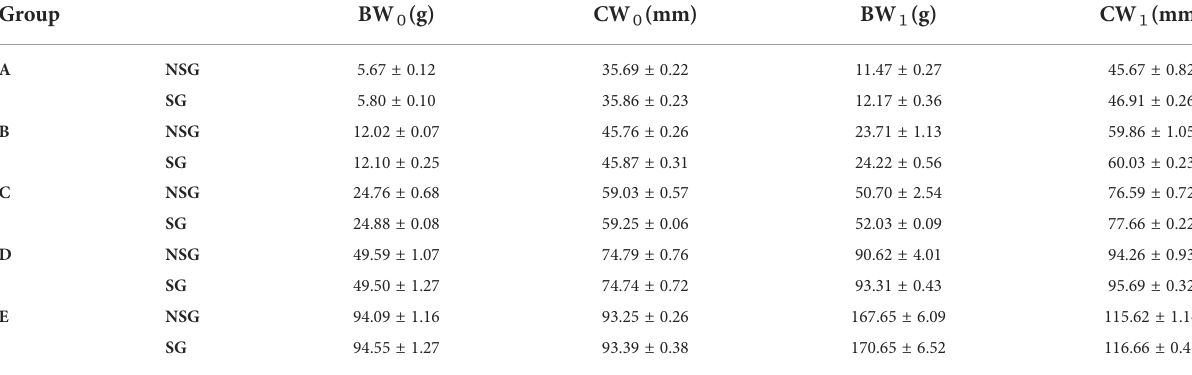
TABLE 1 Changes in body weight and carapace width of swimming crab with different body weight in the NSG and SG. Group